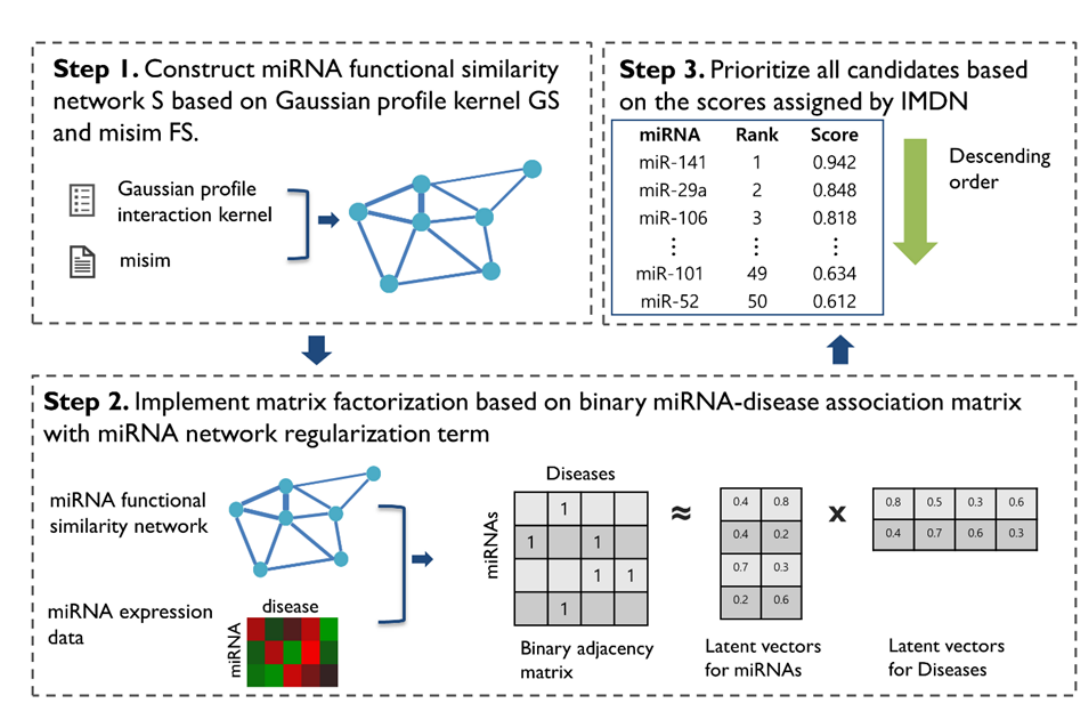
Figure 1. Workflow of IMDN. First, the functional similarity network in which node is miRNA was